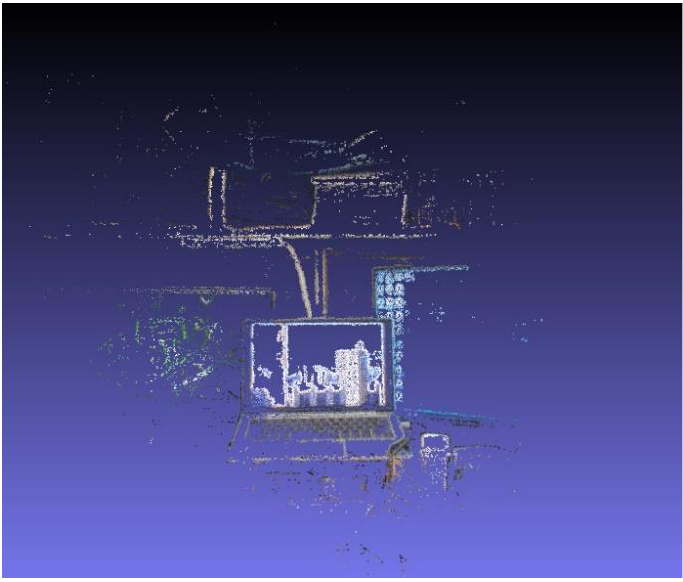
Figure 16. Three-dimensional reconstruction results of images shot by a monocular camera.